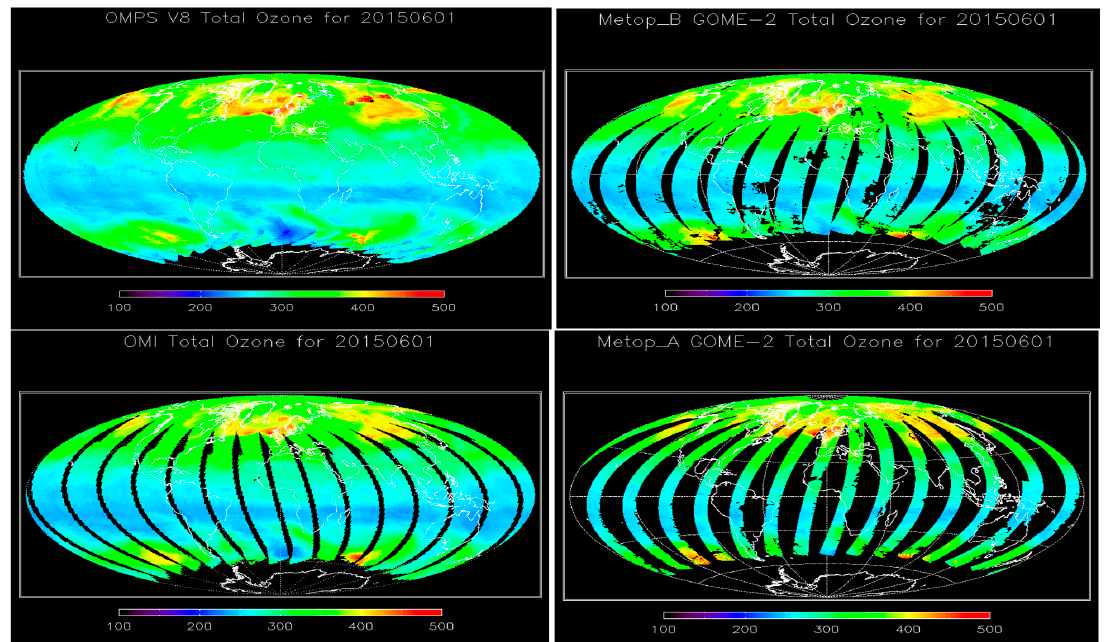
Figure 14. OMPS total column ozone products (in Dobson Units) from MetOp-B GOME-2 (NOAA Version 8 algorithm), NASA EOS Aura OMI (NASA Version 8.6 algorithm) and S-NPP OMPS-NM (NOAA Version 8 algorithm) for 1 June 2015. (Figure courtesy: Lawrence E Flynn, STAR OMPS Ozone team).